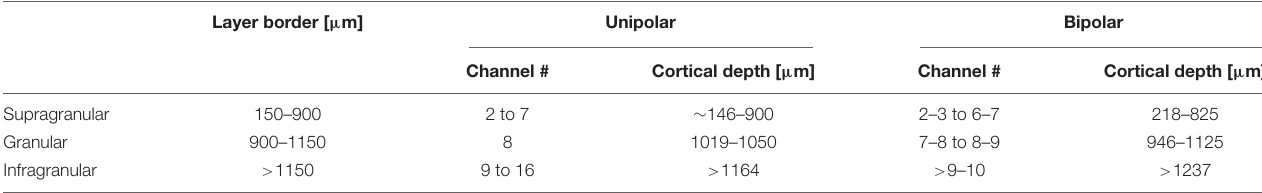
TABLE 1 | Cortical depths for each electrode of the probe in A1 over the range of deviations between 0 ◦ and 14 o from perpendicular as observed in the present experiments. Layer border [ µ